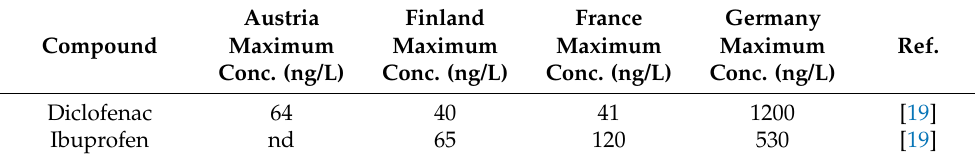
Table 2. Concentrations of diclofenac and ibuprofen found in surface waters [15].